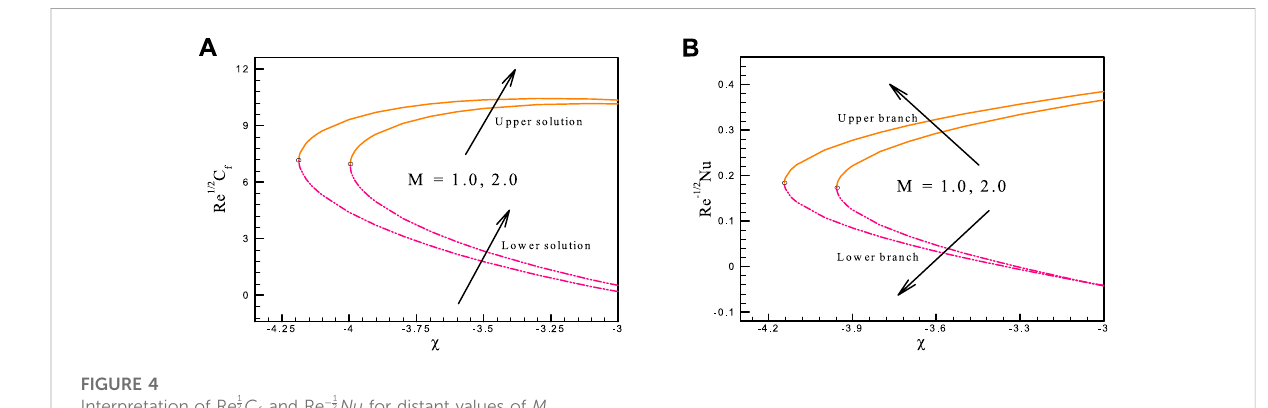
FIGURE 4 Interpretation of Re 1 2 C f and Re − 1 2 Nu for distant values of M